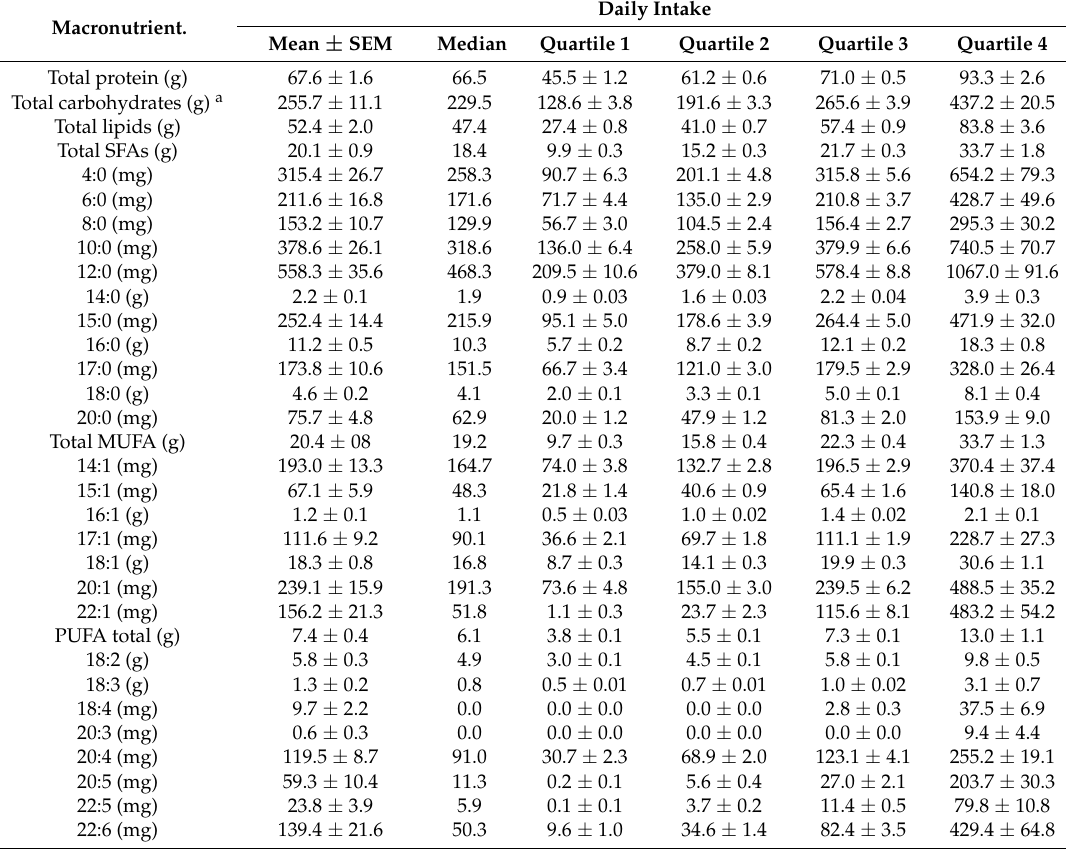
Table 2. Dietary macronutrient and fatty acid intakes among postmenopausal women.